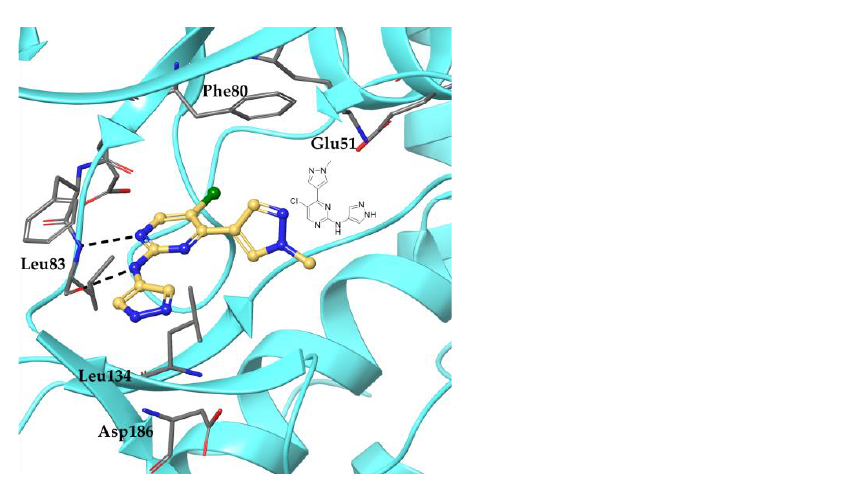
Figure 3. Compound 15 docked into CDK2/cyclin E (PDB ID: 7KJS). The kinase is presented in cyan ribbons with selected amino acids annotated, while 15 is colored yellow. Hydrogen bonds are indicated by dashed black lines. The illustration was generated using Maestro Schrödinger Release 2021-1.